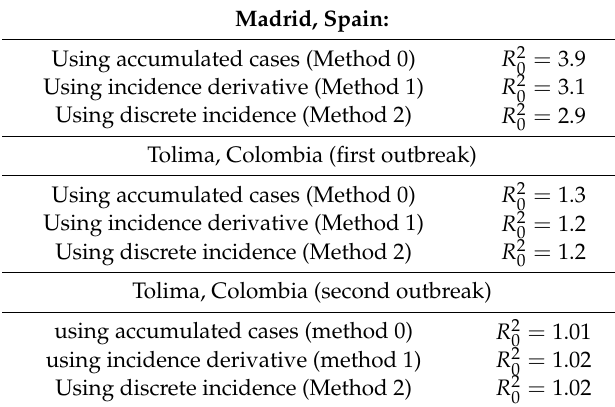
Table 7. Comparison of estimates of the basic reproduction number for the